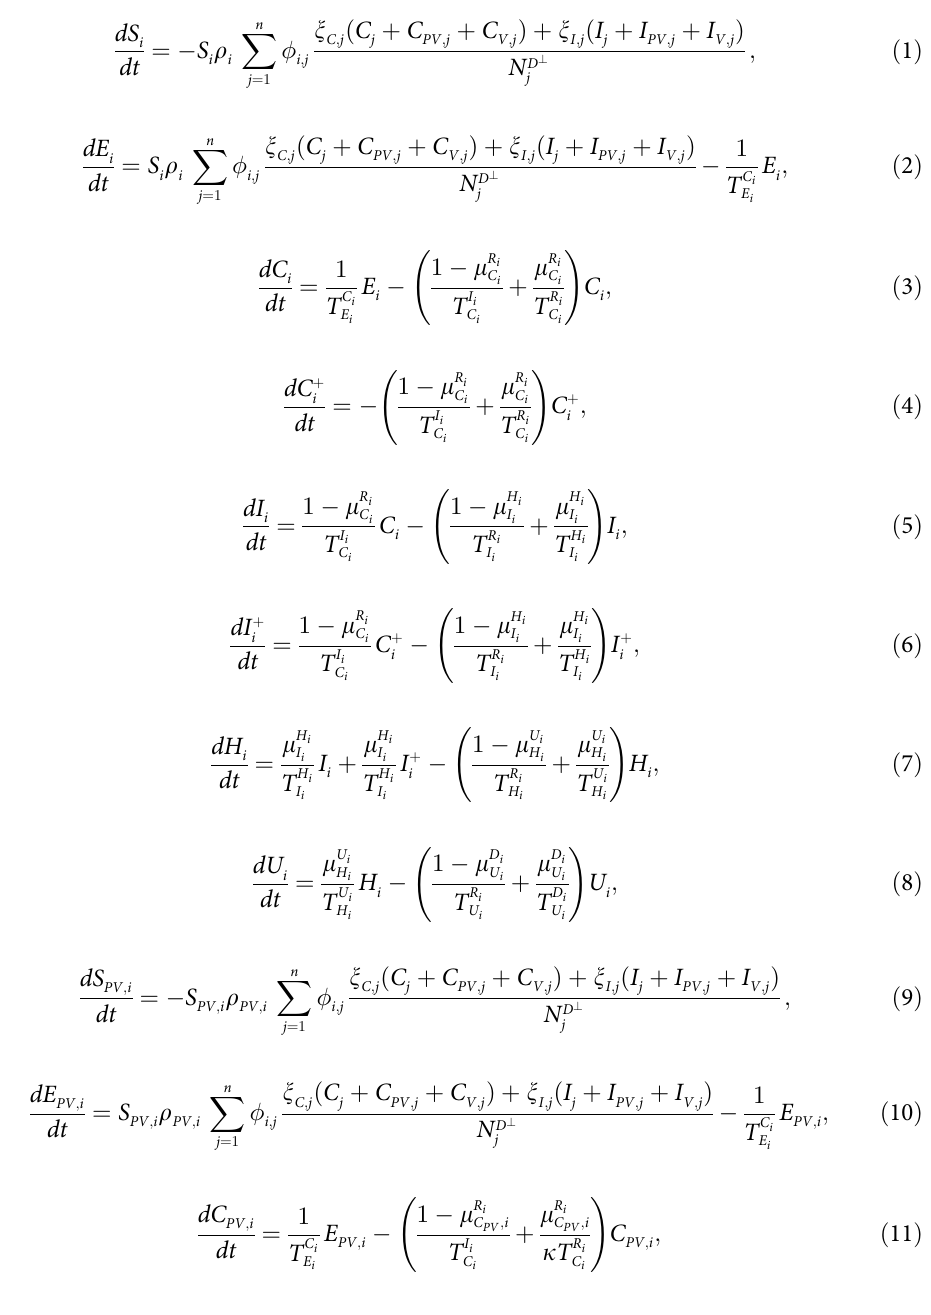
; E ; C ; . . . g as the set of ≔ f S i i i i P ≔ z as the sum of all living individuals of age i z 2 Z i n D i